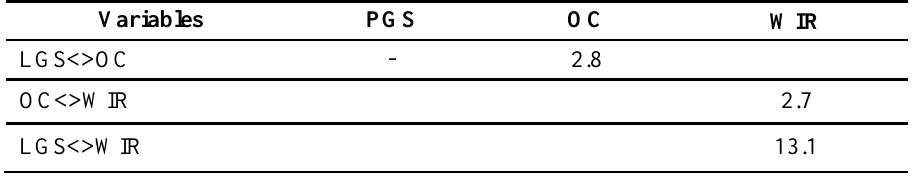
Table.4. Total indirect